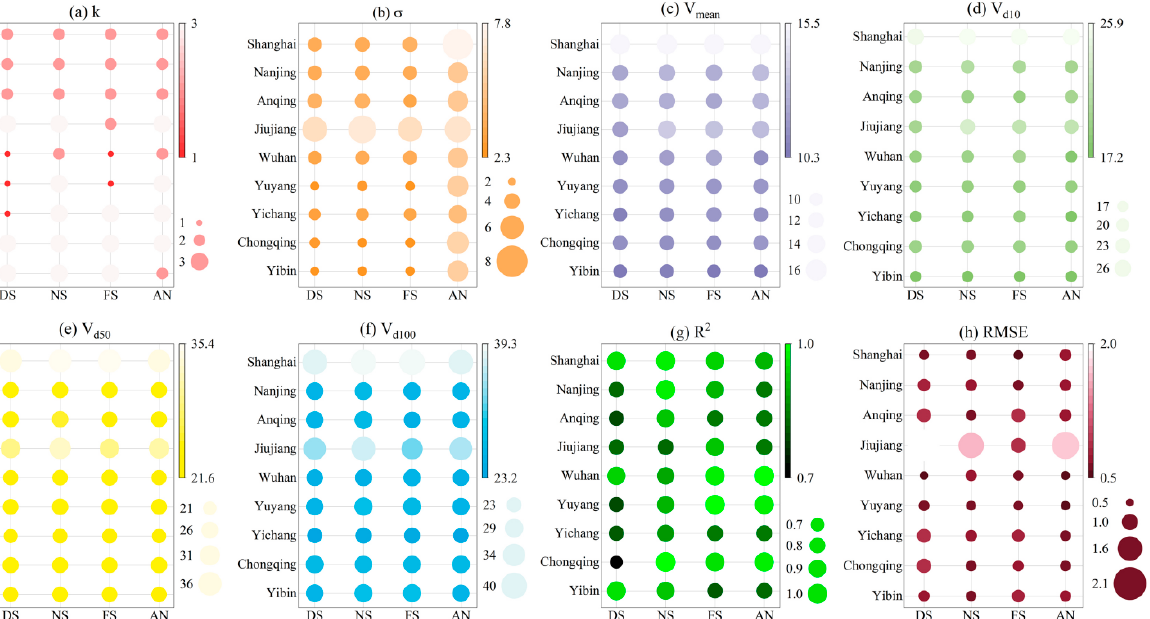
Figure 5. probability ‒ wind speed plots of the cumulative GEV distribution for nine ports from 1979 ‒ 2020 (Dotted line: observed wind speed; red line: theoretical wind speed).